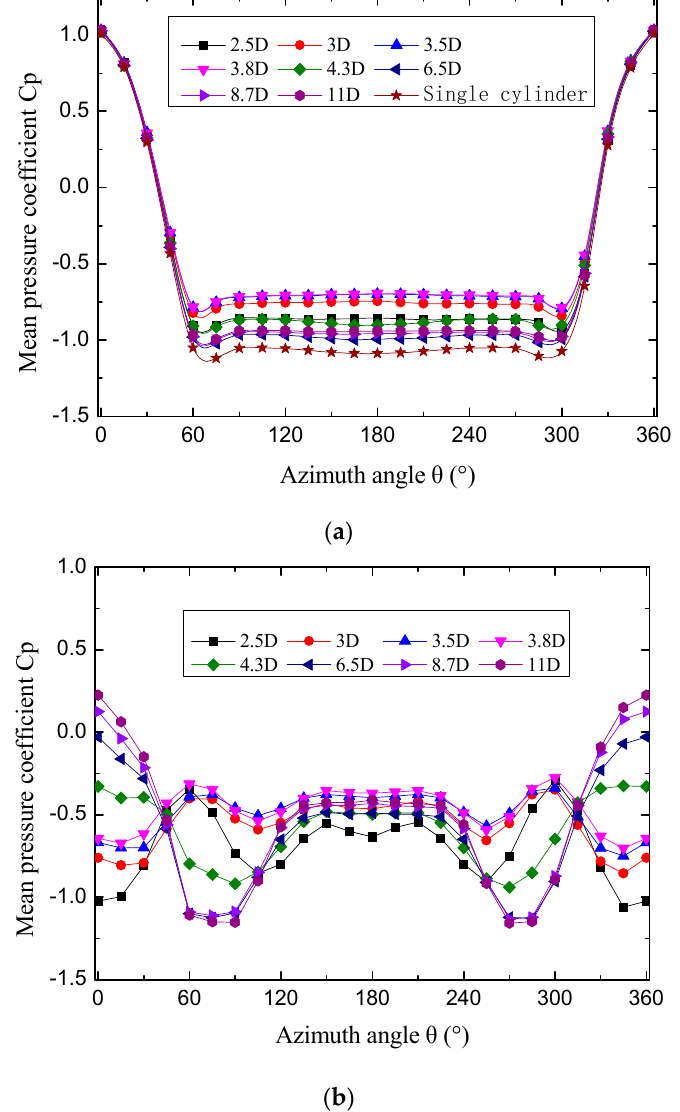
Figure 4. Distributions of time–mean pressure coefficients on cylinders at α = 0 °: ( a ) upstream cylinder; ( b ) downstream cylinder.